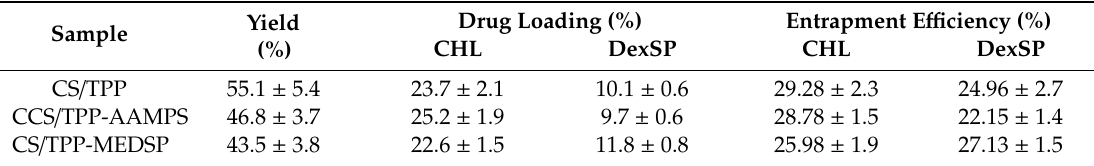
Table 3. %yield of nanoparticlesand %drug